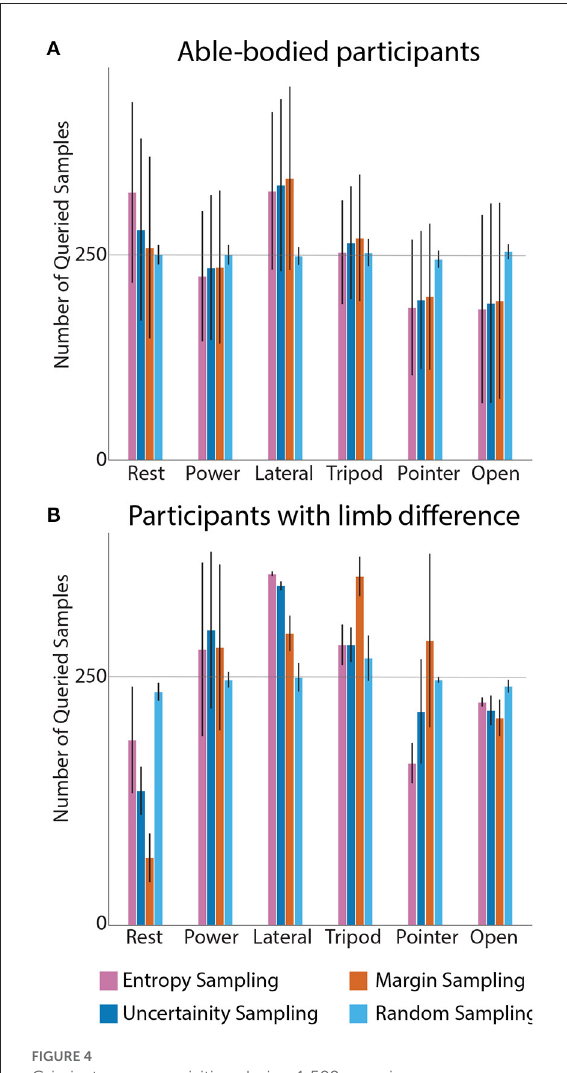
FIGURE4 Grip instances acquisition during 1,500 querying process across all the subjects: able-bodied participants (A) and people with limb difference (B) . Query strategies are compared against class. In (A) , the highest demand for new instances within 1,500 queries was for the lateral grip. The pointer grip and hand open classes needed the fewest samples. In contrast to able-bodied participants, active learning requested fewest samples for the rest class. In all cases, random sampling drew 250 samples on average.